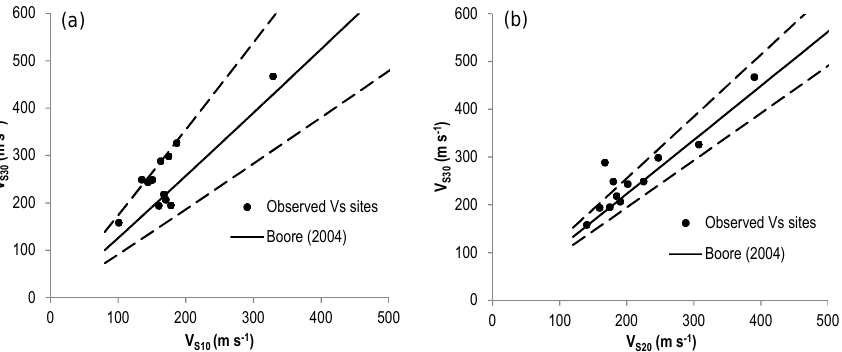
Figure 4. Plots comparing observed V S30 with V S30 estimated from Boore (2004) equations, with respect to observed V S10 (a) and observed V S20 (b) . The dashed lines represent the 95% confidence interval around the Boore (2004) relationships. V S30 is the average shear-wave velocity in the top 30m of ground and V S10 and V S20 are the equivalents at 10 and 20m depth respectively.